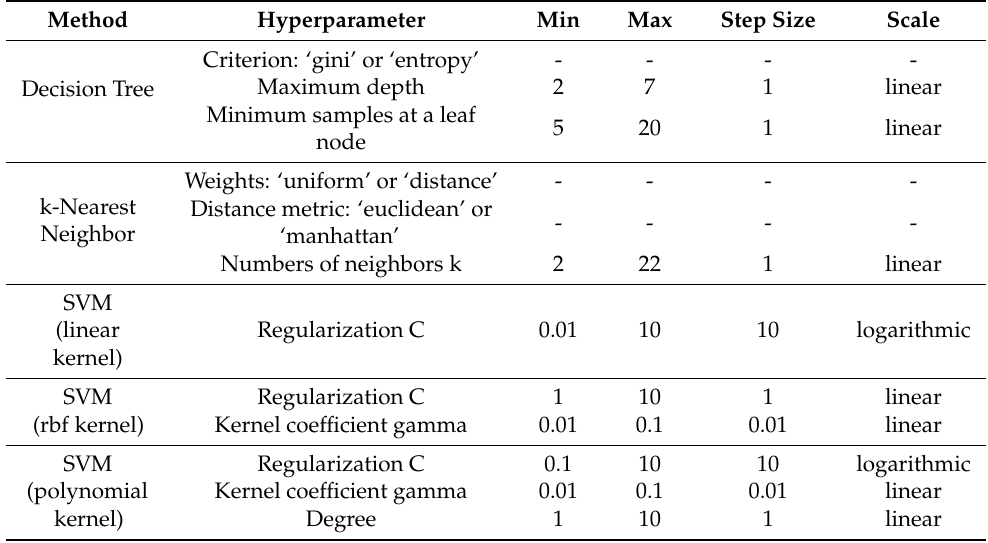
Table 2. Range of hyperparameters optimized with grid search; SVM = Support Vector Machine; rbf = radial basis